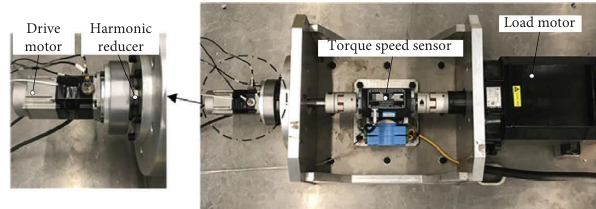
Figure 4: Harmonic reducer test